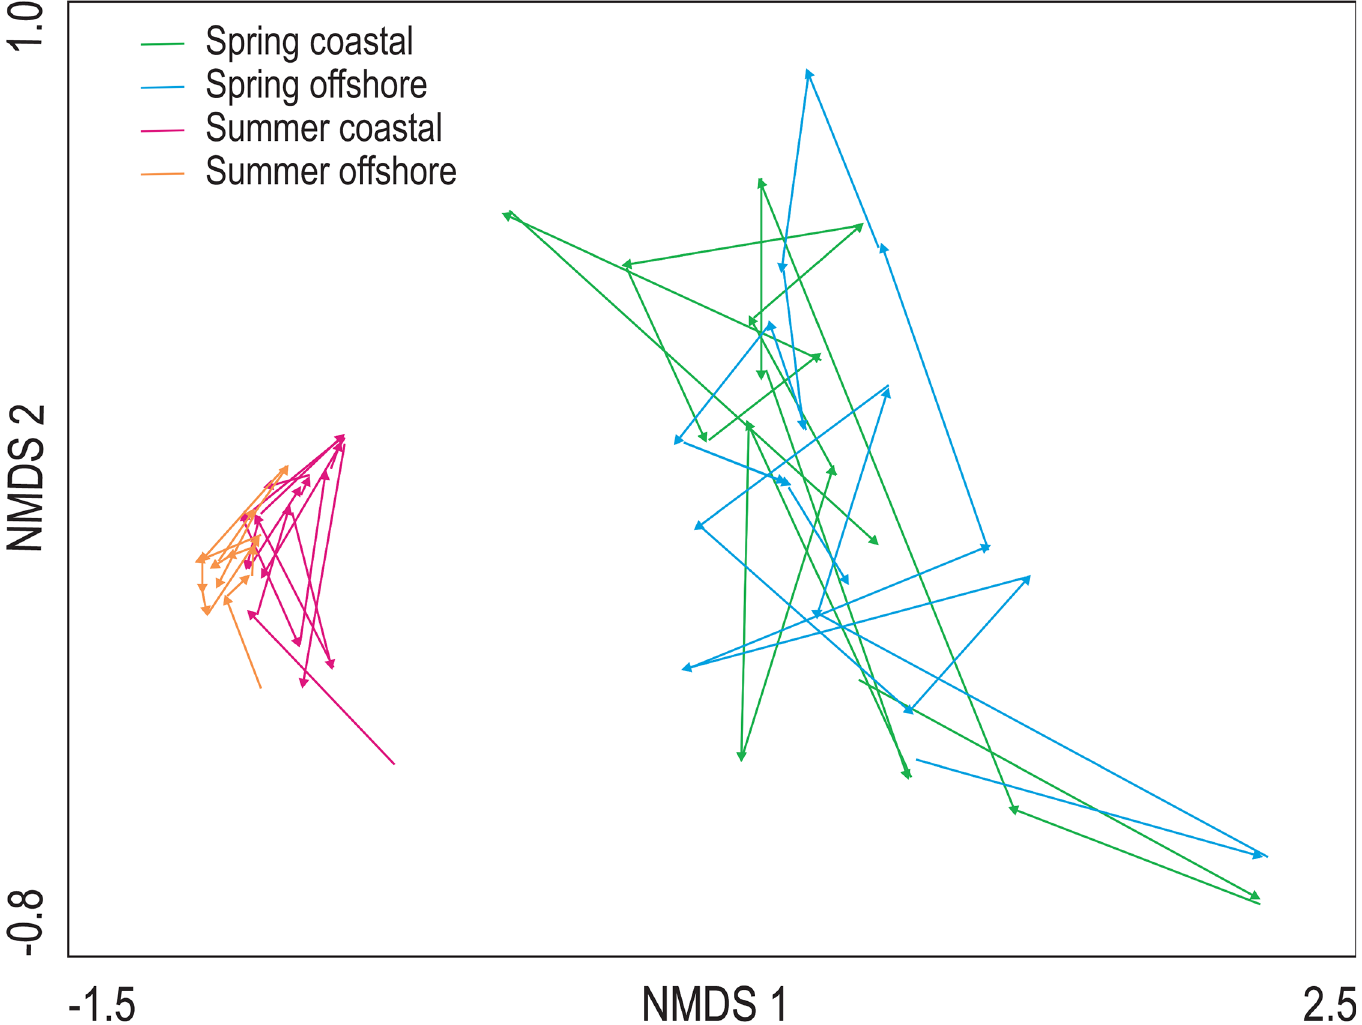
Fig 4. Multivariate ordination. Nonmetric multidimensional scaling (NMDS) ordinations showing seasonal averages of water quality trajectories during spring and summer in the coastal and offshore site between 1994 and 2011. The length of each arrow reflects change from one sampling year to the